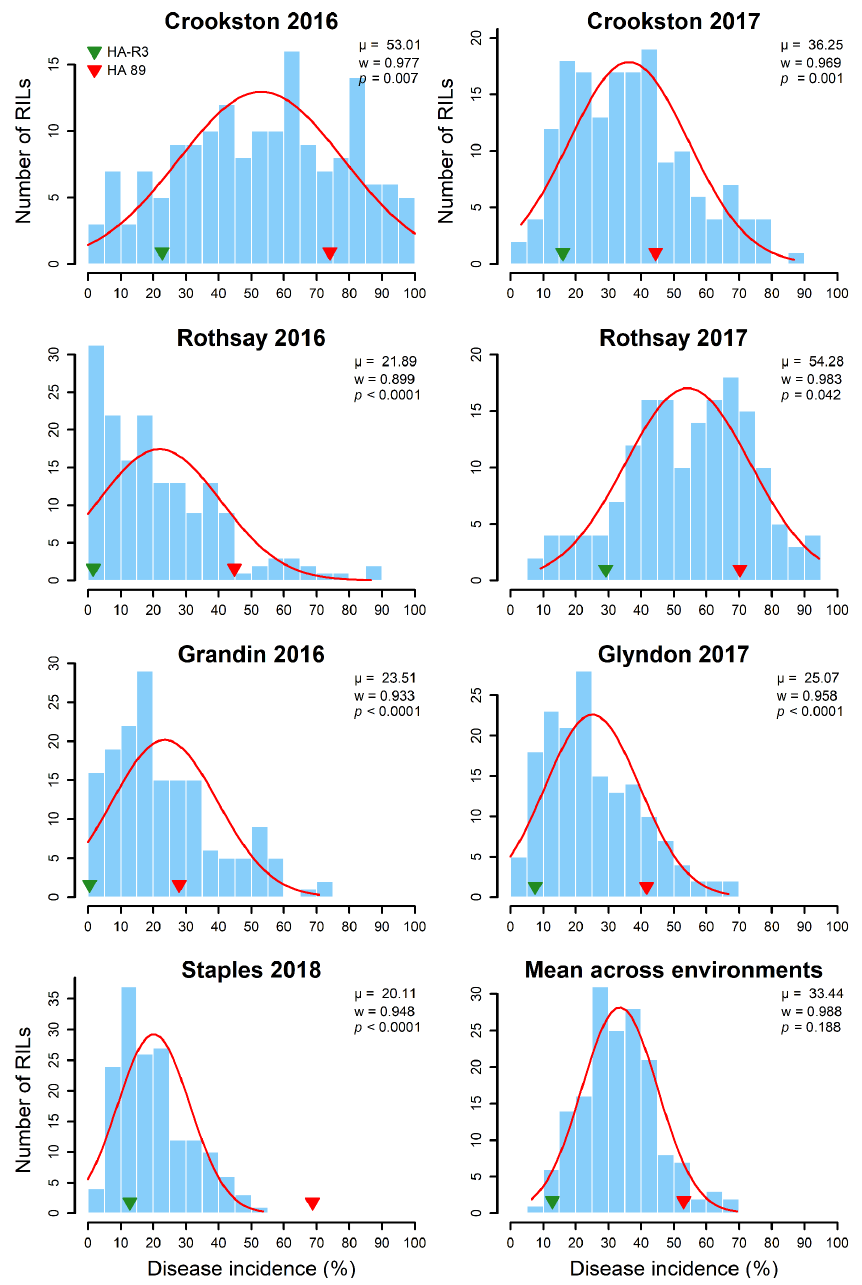
Figure 1. Frequency distribution of Phomopsis stem canker disease incidence (DI) among 164 sunflower recombinant inbred lines tested in multiple environments during 2016 to 2018. The arrowheads indicate the DI levels of the parental lines, HA-R3 (green) and HA 89 (red). The Shapiro–Wilk normality test statistic ( w ), the probability value ( p ), and the mean ( µ ) of the data for each environment are shown inside the respective plots.